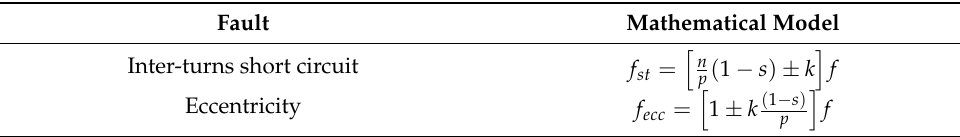
Table 1. Frequency components associated with faults